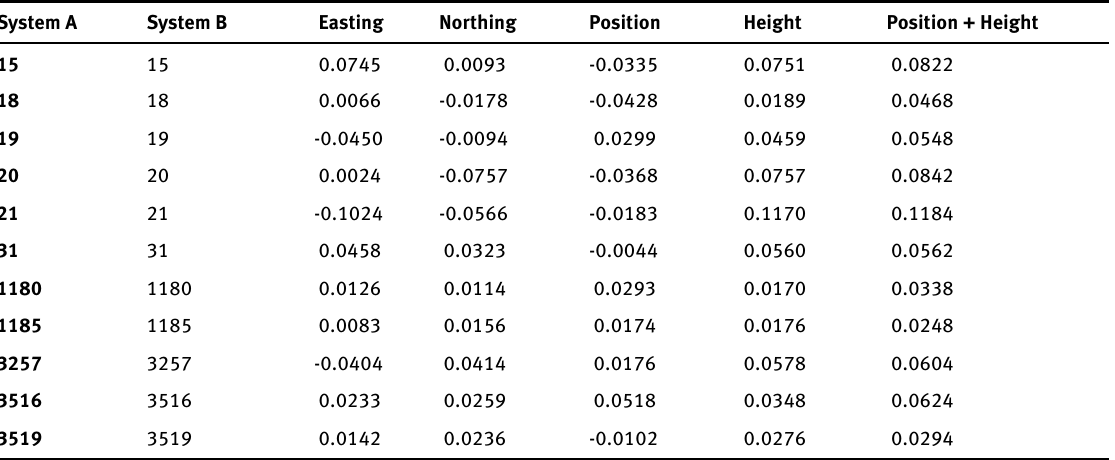
Table 1. Leica Geo Office results for Twostep transformation © ÖAW/IKAnt (M. Hernández Cordero).